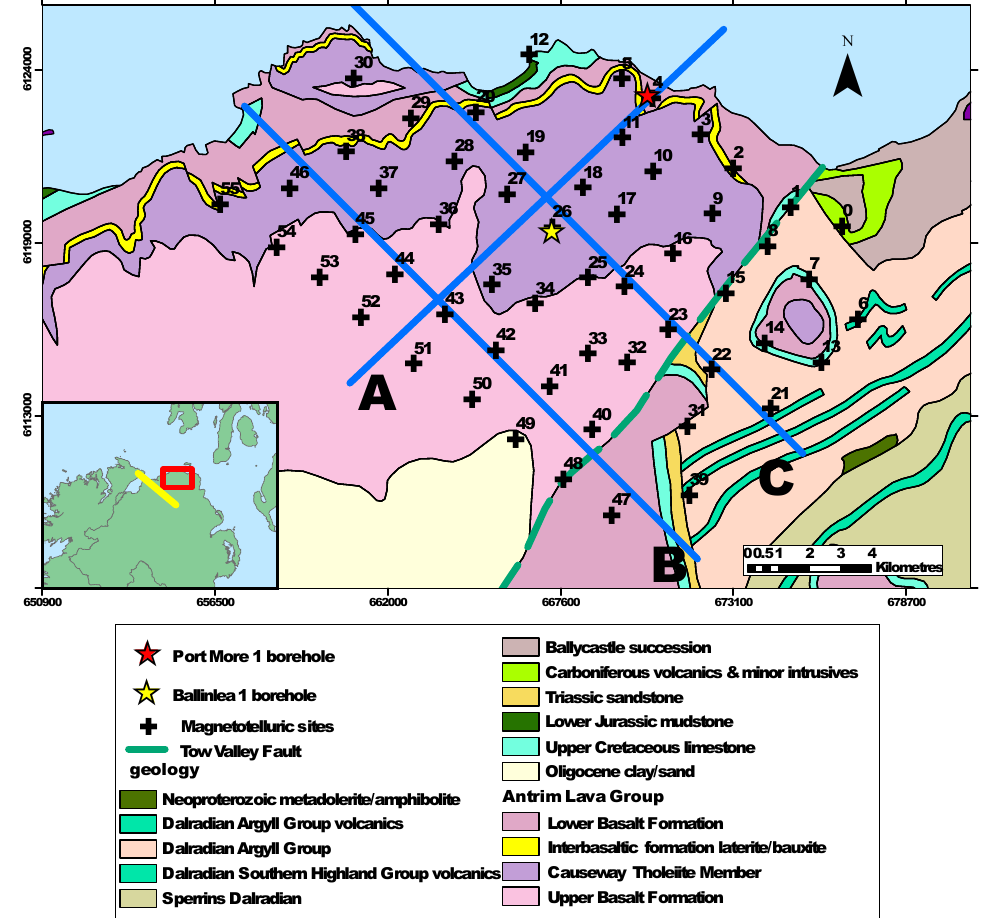
Figure 1. Geological map of Rathlin Basin area, overlain with magnetotelluric acquisition sites numbered and denoted by black crosses. Note the large areal extent of the Antrim Lava Group basalts, with minimal surface expression of the underlying sedimentary basin. Profiles A, B, and C denote the locations corresponding to Figs. 12–14. Inset map shows the northern half of Ireland, with the location of the magnetotelluric survey area shown by the red rectangle. The yellow line indicates the location of the density profile shown in Fig.